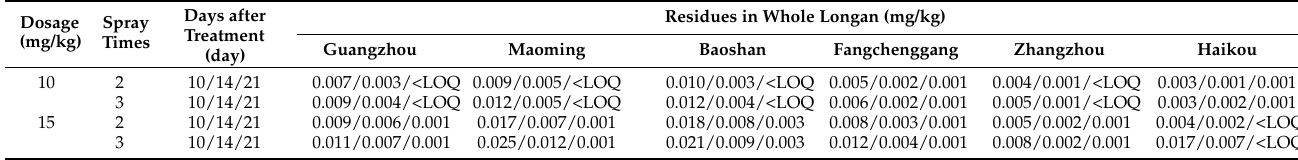
Table 2. Terminal residues of emamectin benzoate in whole